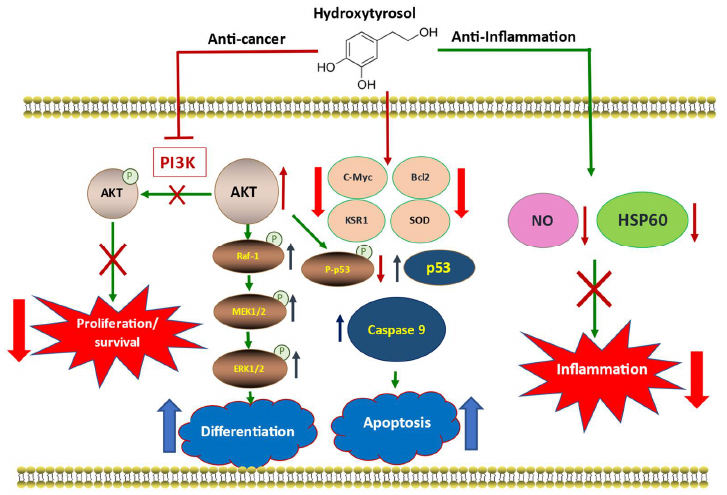
Figure 10. Schematic representation of the main molecular events responsible for the anti-cancer and anti-inflammatory capacity of hydroxytyrosol. The incorporation of HT into the cell triggers a profound inhibition of PI3K activity within the AKT/PI3K signaling pathway. This inhibition allows AKT to avoid phosphorylation, keeping its activity intact, generating a series of molecular changes that lead to a decrease in the proliferation and survival of cancer cells together with an increase in cell differentiation and apoptosis. The activity of AKT facilitates the development of the MAPK pathway through MEK 1/2 /ERK 1/2 , which together with a decrease in the expression levels of c-Myc and KSR1 favors cell differentiation. In addition, HT reduced the levels of the inactive form of p53, increasing the levels of the active form, as well as those of caspase 9 and induced a decrease in the anti-apoptotic protein Bcl-2, which led to a significant increase in the recognition of apoptosis of cancer cells. In parallel, the significant reduction in inflammation caused by the administration of LPS together with a drastic decrease in the expression levels of HSP60 and SOD after treatment with HT allows us to recognize the important anti-inflammatory activity of this natural polyphenol.